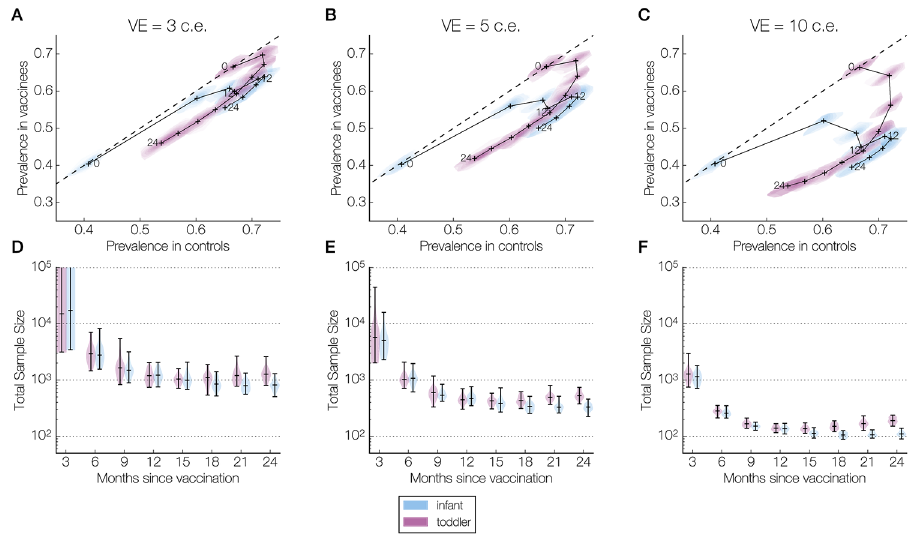
Fig 3. Prevalence and sample size over the follow-up period in the lower transmission setting. Panels are organized column-wise by wSP vaccine efficacy: 3 colonization equivalents (c.e.), or 26% reduction in carriage duration (A, D); 5 c.e., or 39% (B, E); and 10 c.e., or 63% (C, F). Within each panel, results are presented separately for infants (blue) and toddlers (purple). (A-C) The joint kernel density estimate (see Methods) of the control and vaccine arm prevalences at each sampling time (every 3 months until 24 months post-vaccination) is shown as a contour map truncated by the convex hull of the simulated points, with the median values marked by a cross. These crosses are connected chronologically, and those corresponding to 0, 12, and 24 months post-vaccination are labeled. The dashed line indicates equal prevalences in the two arms. (D-F) The kernel density estimate of the total sample size (combined size of both samples) needed to detect a difference between control and vaccine arm prevalences at each sampling time (assuming 80% power, 5% type I error rate, balanced arms). The horizontal bars in each violin plot indicate the minimum, median, and maximum values across all simulations. In (D), the maximum sample sizes for infants and for toddlers at 3 months post-vaccination are greater than one million (510 million and 18 million, respectively) and outside the limits of the